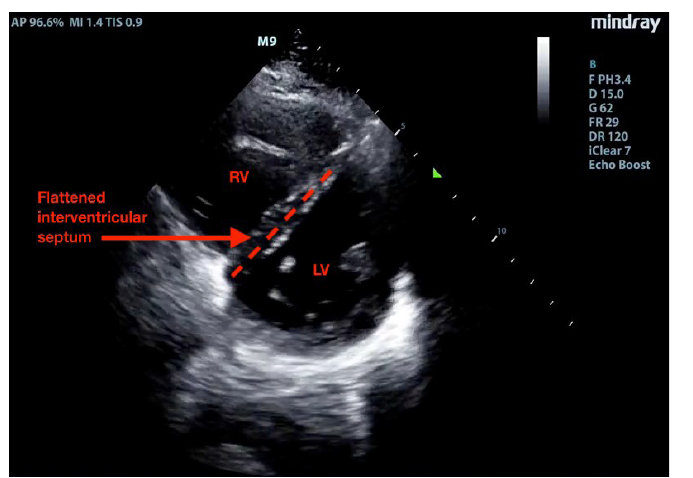
Image 1. Parasternal short view of the heart, demonstrating bowing of the interventricular septum away from the right ventricle (RV) into the left ventricle (LV) (the “D-sign”).